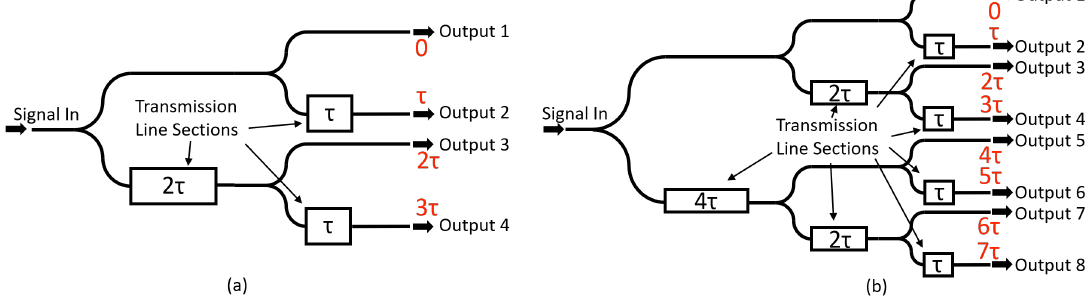
Figure 12. Schematic of the hierarchical true time delay tree beamformer: ( a ) 1 to 4; and ( b ) 1 to